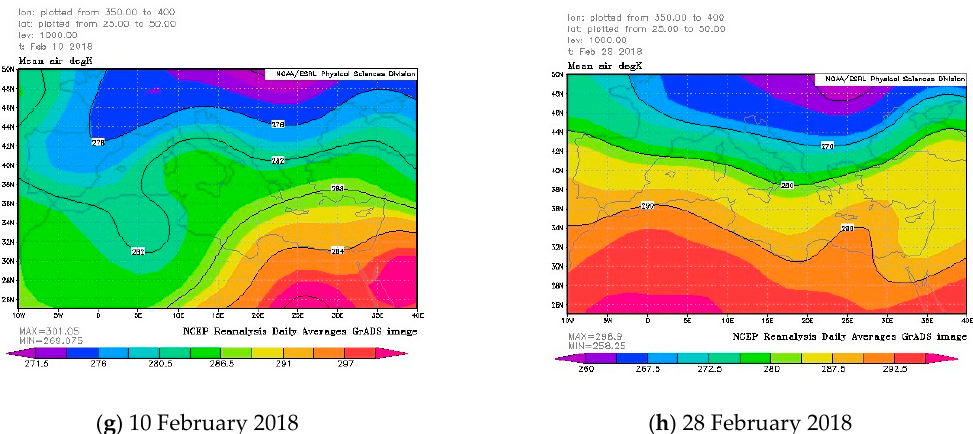
Figure 2. Mean daily air temperature [K] maps at the 1000 hPa level based on NCEP reanalysis daily averages. Average map for the period 1 December 2017–28 February 2018 and some selected daily maps.